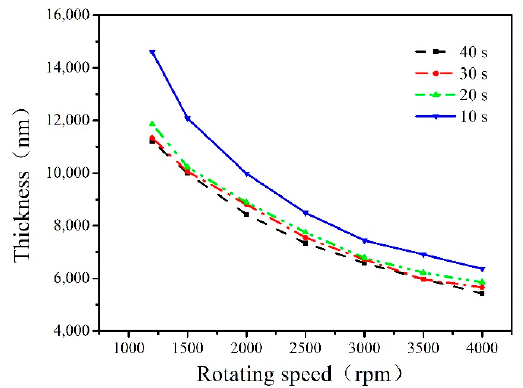
Figure 6. The relationship between the spin speed, spin time and the thickness .